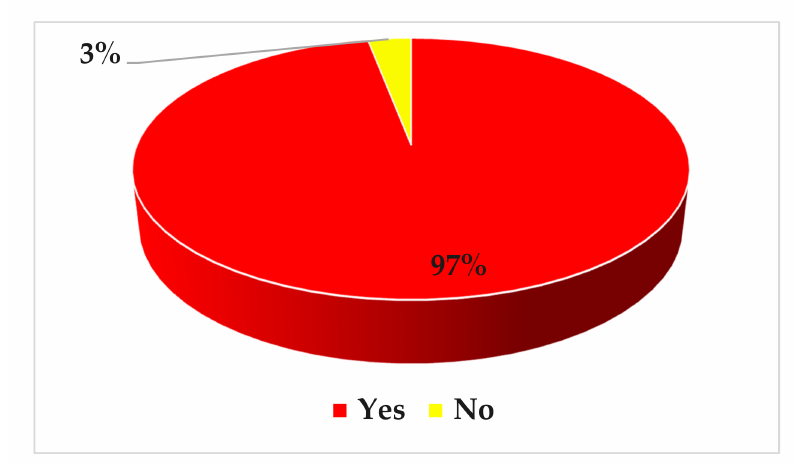
Figure 7. Characteristics of respondents based on mobile phone ownership.